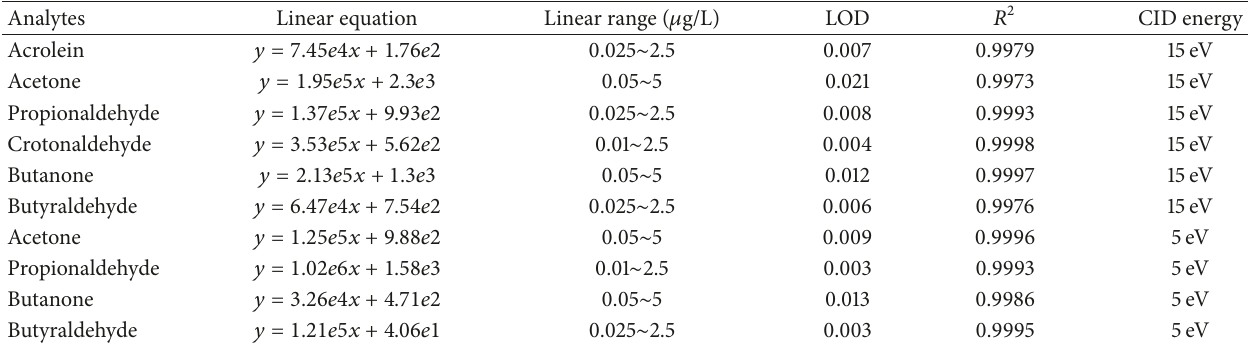
Figure 4: Daughter scan mass spectra of 0.5 𝜇 g/L isomers of low molecular carbonyl compounds under the CID of 5 eV. (a) Propionaldehyde, (b) acetone, (c) butyraldehyde, and (d) butanone. Table 1: Performance parameters of the APCI-MS/MS method for six low molecular carbonyl compounds by daughter scan mode with [CH 3 O] +